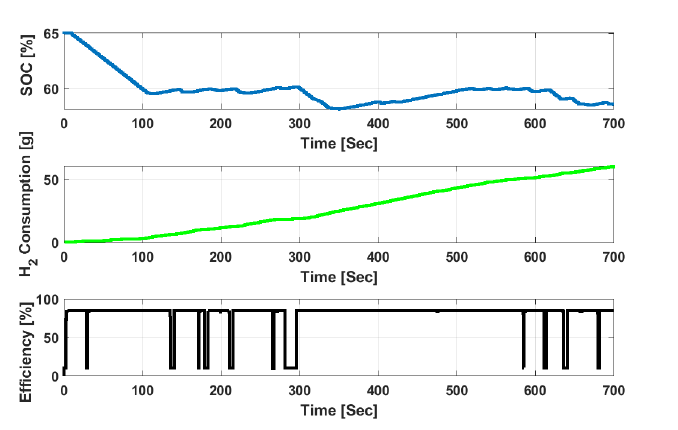
Figure 14. Power demand ( P demand ), FC power ( P FC ), battery power ( P bat ), and supercapacitor power ( P SC ) for the EMS based on the FCFCMS.